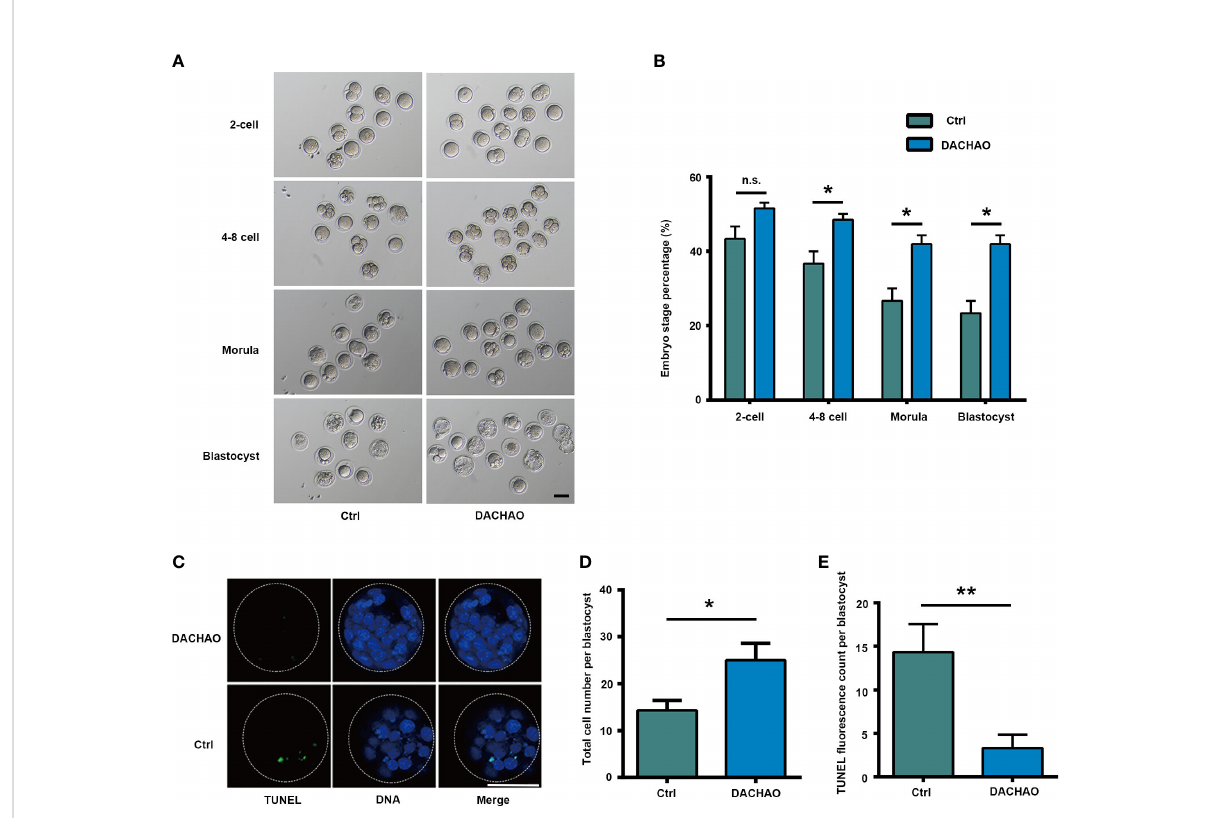
FIGURE 3 The improvement of DACHAO treatment on in vitro embryonic development in aged mice. (A) Developmental morphology of embryos at different stages after IVF in each group. (B) Statistical graph of the ratios of different stages of embryonic development in each group (n=72). (C) TUNEL and Hoechst33342 fl uorescence staining of blastocysts in each group. (D, E) Statistical graphs of the total number of blastocyst cells and the number of TUNEL fl uorescent staining positive signal points in each group (n=16). Data are presented as means ± SEM of three independent replicates. *P < 0.05 and **P < 0.01, and n.s. P ≥ 0.05, compared with the control group. n = the total number of embryos in the 2 groups of 3 repetitions. All bars =50 m